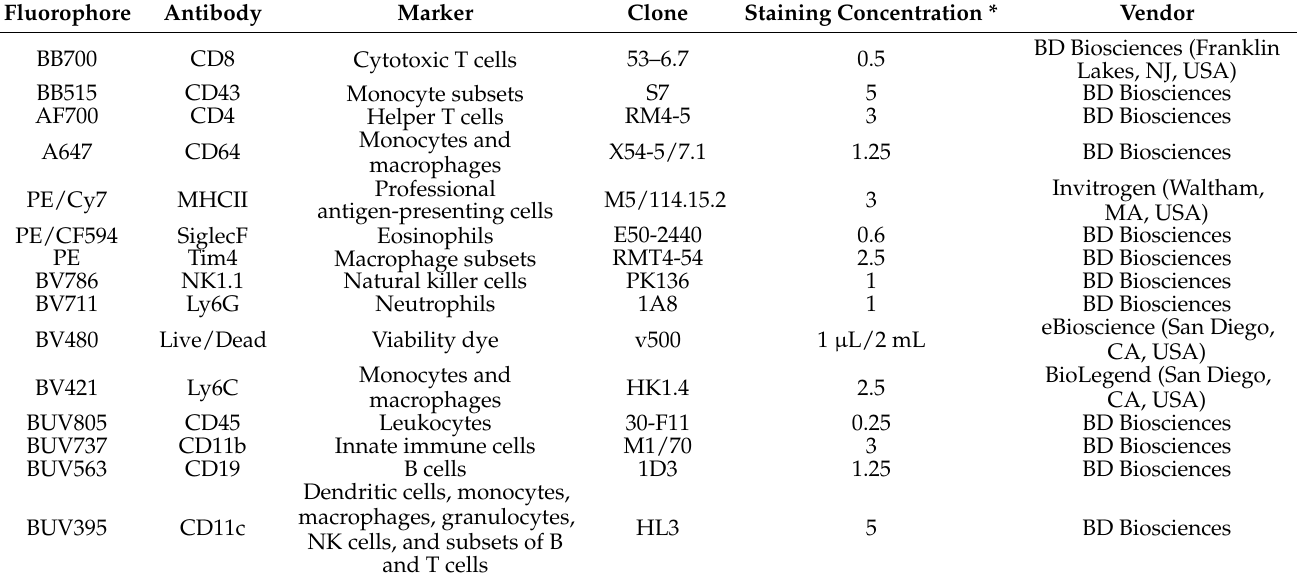
Table 1. Antibody staining panel and optimal staining concentration for approximately 1 × 10 5 cells in 50 µ L